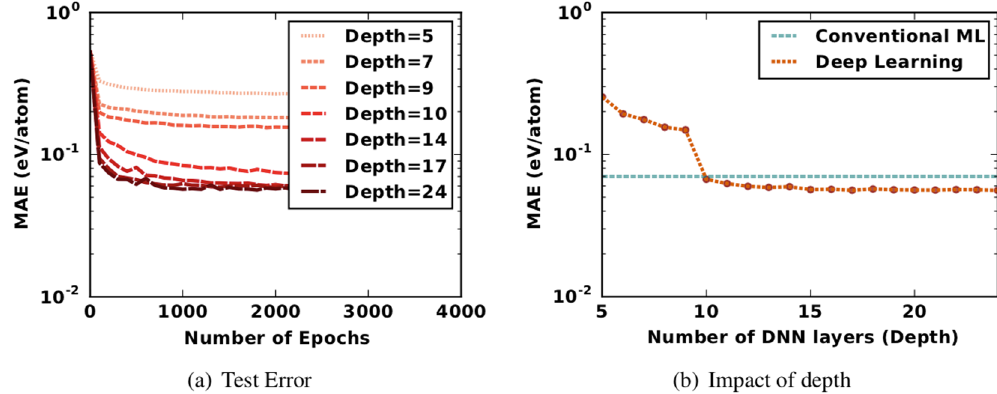
Figure 2. Performance of deep learning models of different depths in model architecture. The models are trained and tested on the lowest DFT-computed formation enthalpy of 256, 622 compounds. Here, we present the impact of depth of architecture for one sample split from our ten-fold cross validation. ( a ) Shows the mean absolute error (MAE) on the test dataset of 25, 662 compounds with unique compositions at different epochs for one split from the cross validation. The DNN models keep learning new features from the training dataset with the increase in the number of layers up to 17 layers, after which they begin to slowly overfit to the training data. ( b ) Shows the MAE for different depths of deep learning model architectures and also illustrates mean absolute error of the best performing conventional ML model trained using physical attributes computed on the same training and test sets. The deep learning model starts outperforming the best performing conventional ML model with an architecture depth of 10 layers, achieving the best performance at 17 layers, we refer to the best performing DNN model as ElemNet . The detailed architecture for ElemNet is available in the Method